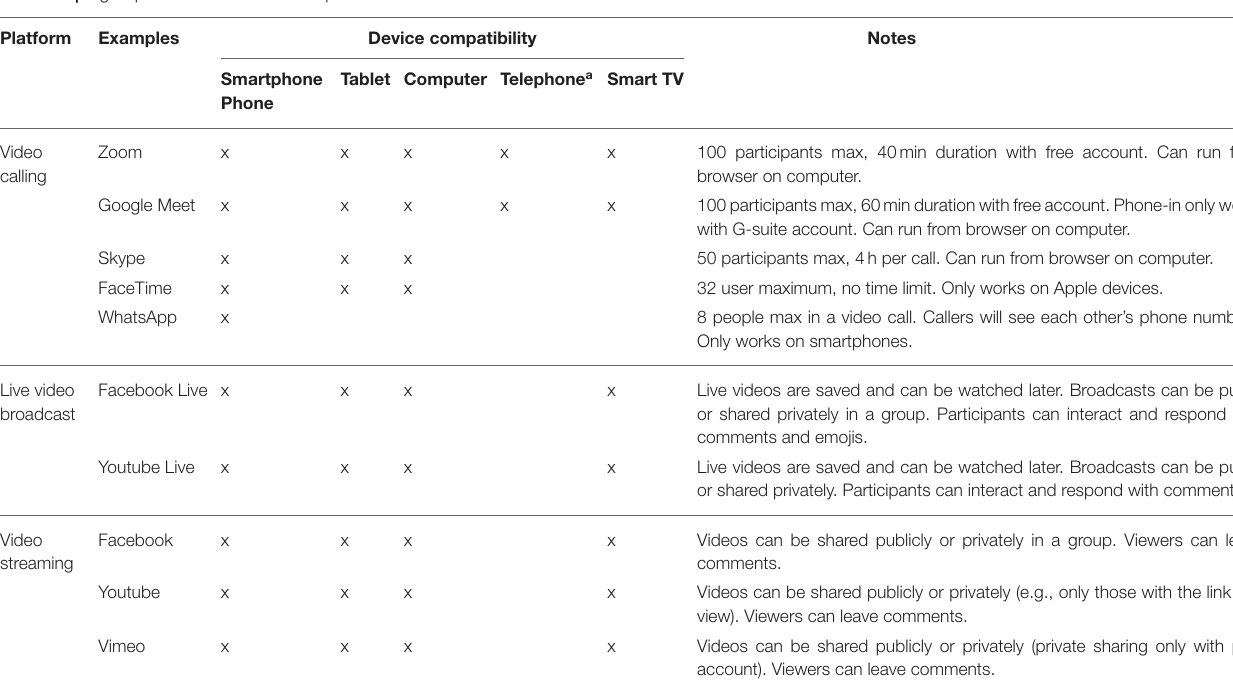
TABLE 3 | Digital platforms used for music